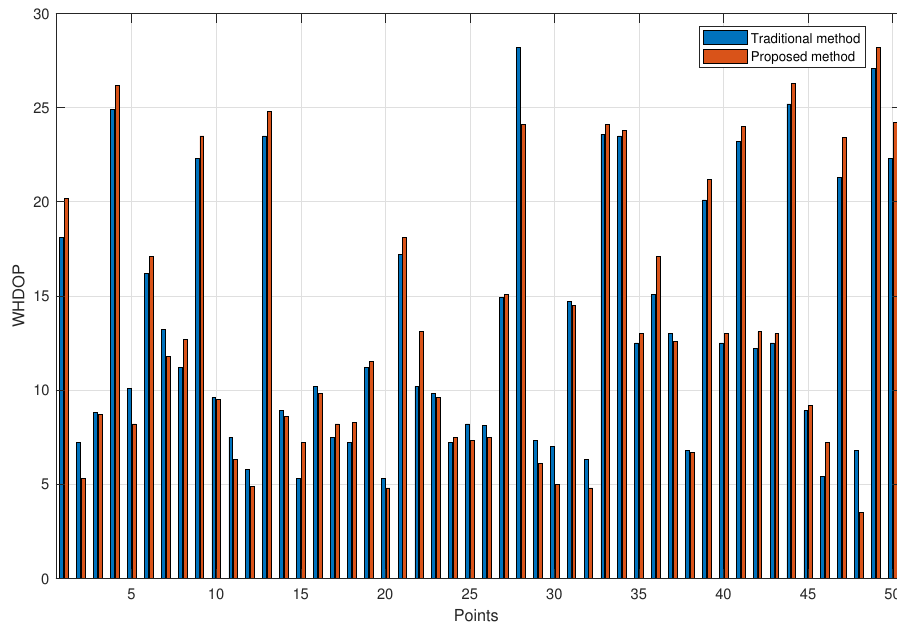
Figure 2. The value of WHDOP under six pseudolites by two different calculation